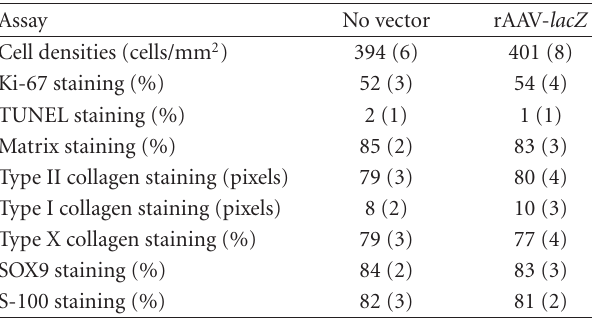
Table 2: Histomorphometric analyses in transduced human chon- drosarcoma cells in situ (day